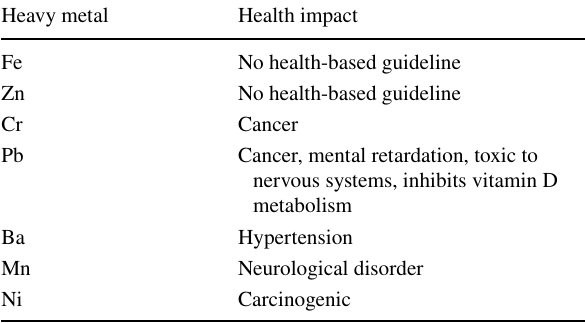
Table 10 Health risks of the analyzed heavy metals (NIS 2007;